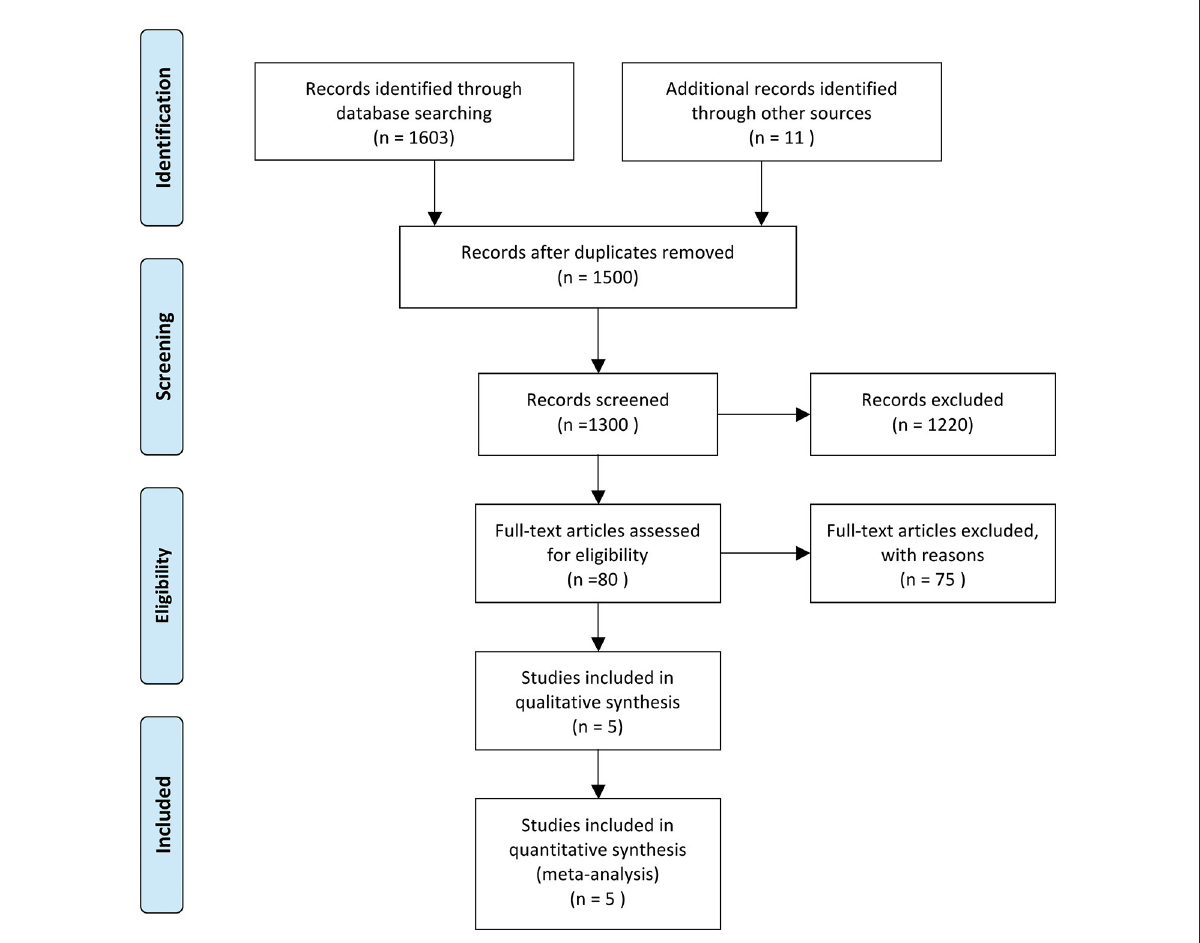
FIGURE1 Literature searching followed PRISMA 2015. From Moher et al.